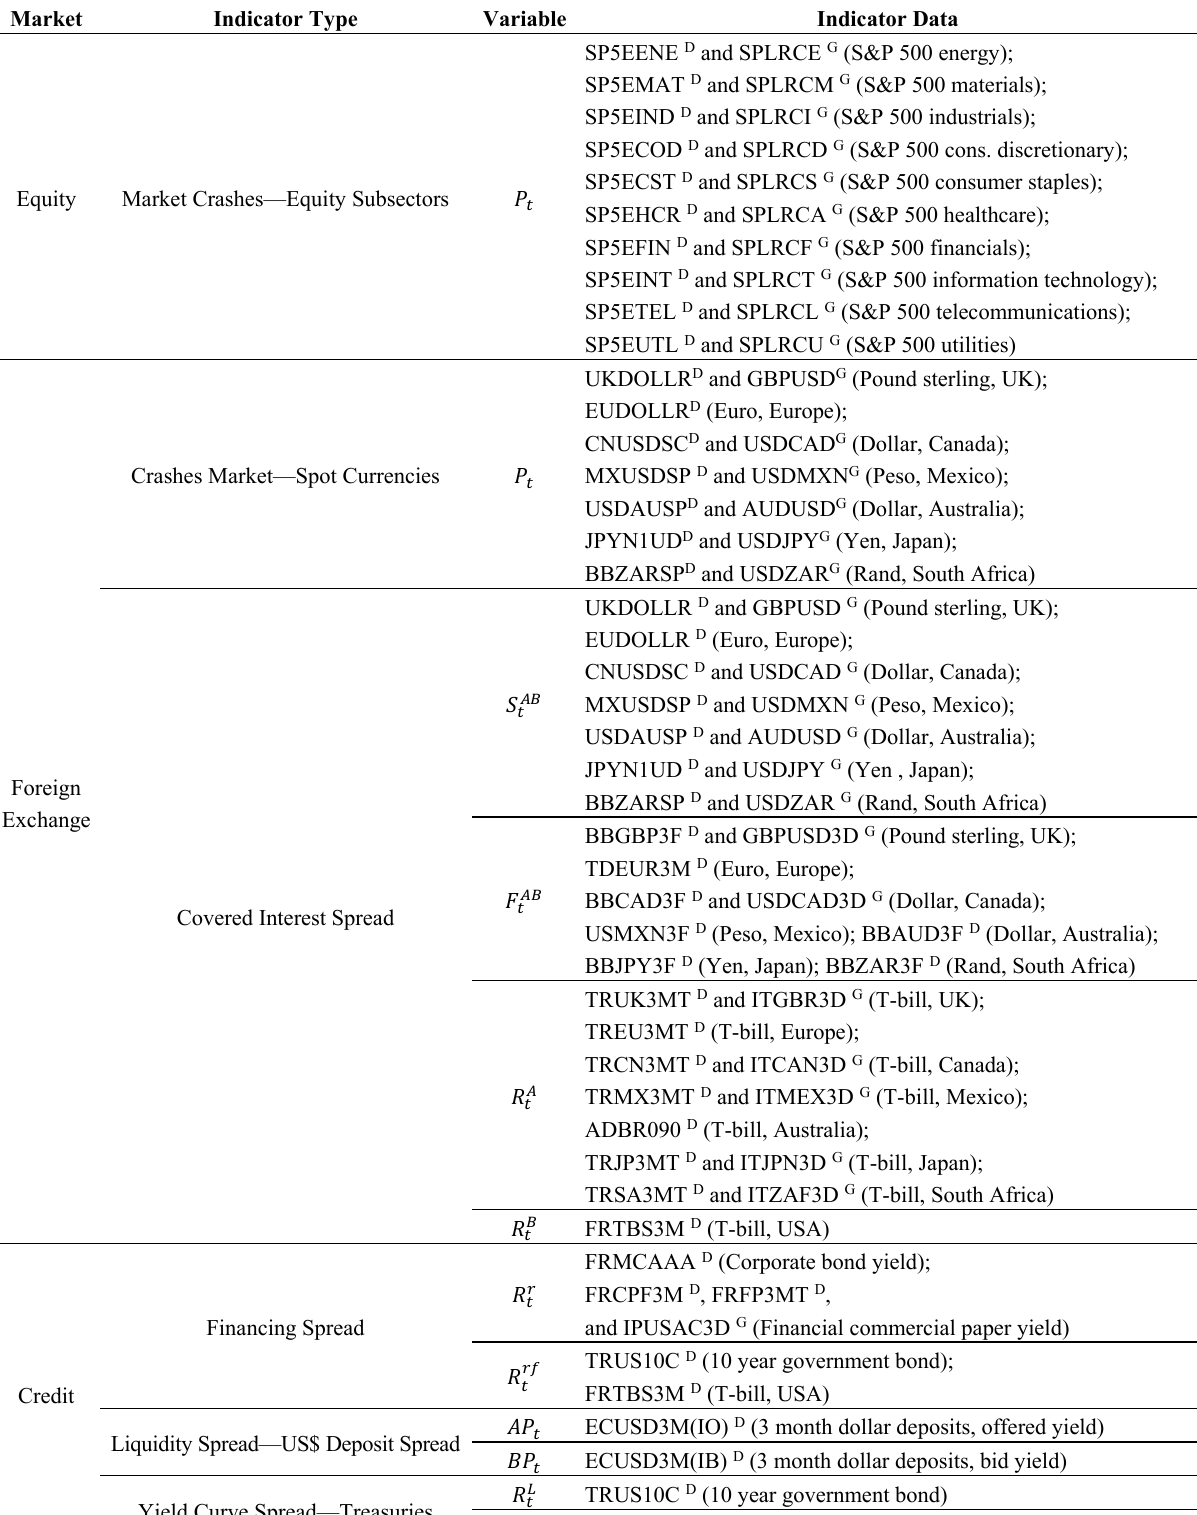
Table 1. Description and sources of component